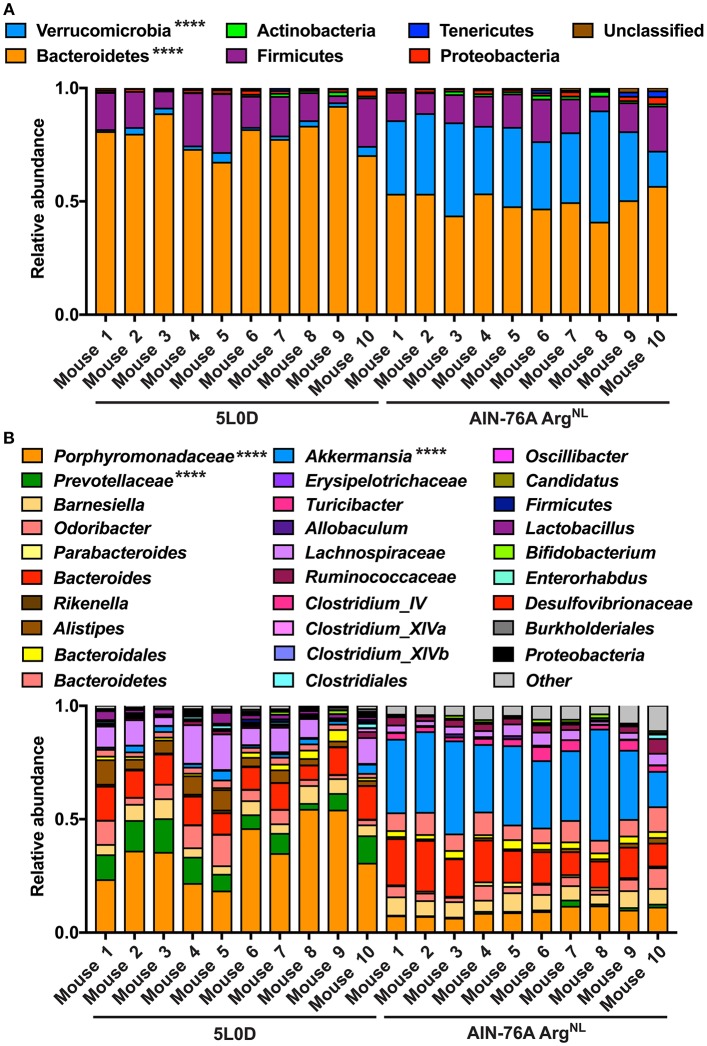
Analysis of the microbiome during diet change. C57BL/6 mice on the 5L0D diet were switched to the AIN-76A ArgNL regimen for 7 days. Feces were collected before the diet change (5L0D) and after the period on the AIN-76A ArgNL diet (AIN-76A). The percentage of each phylum (A) and genus (B) is shown. Mice 1–5 and 6–10 were distributed in two different cages. ****P < 0.0001 denote significant differences between the 5L0D and AIN-76A groups, determined by the Student's paired t test.